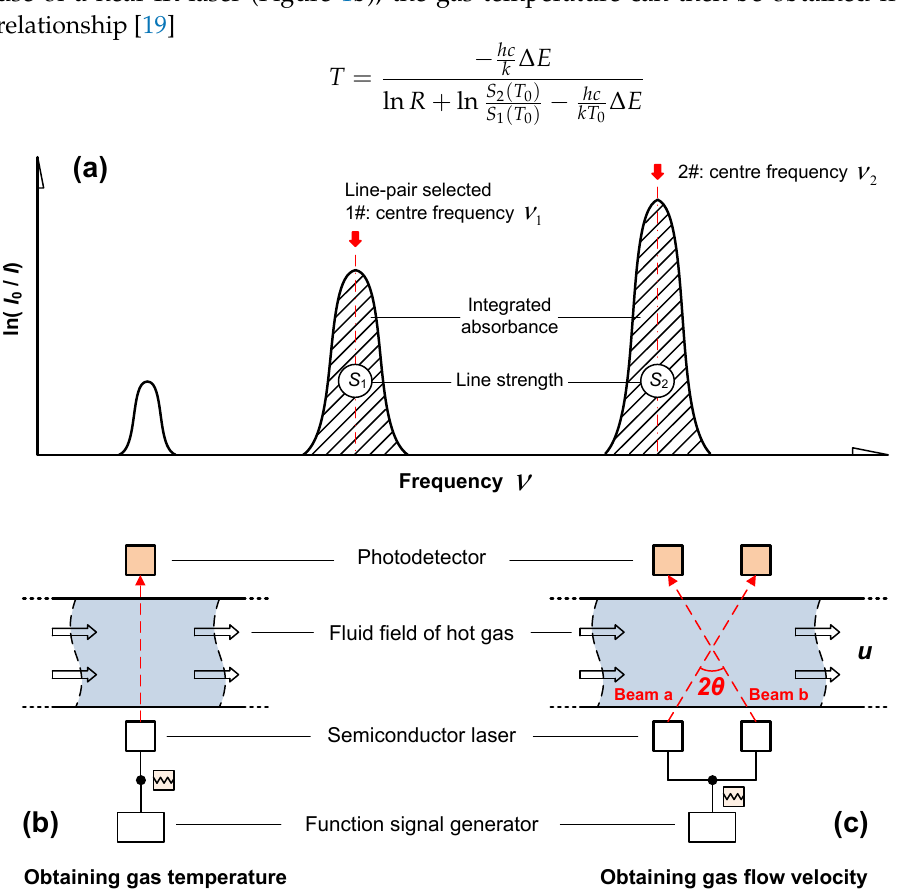
(c)(b) Function signal generator